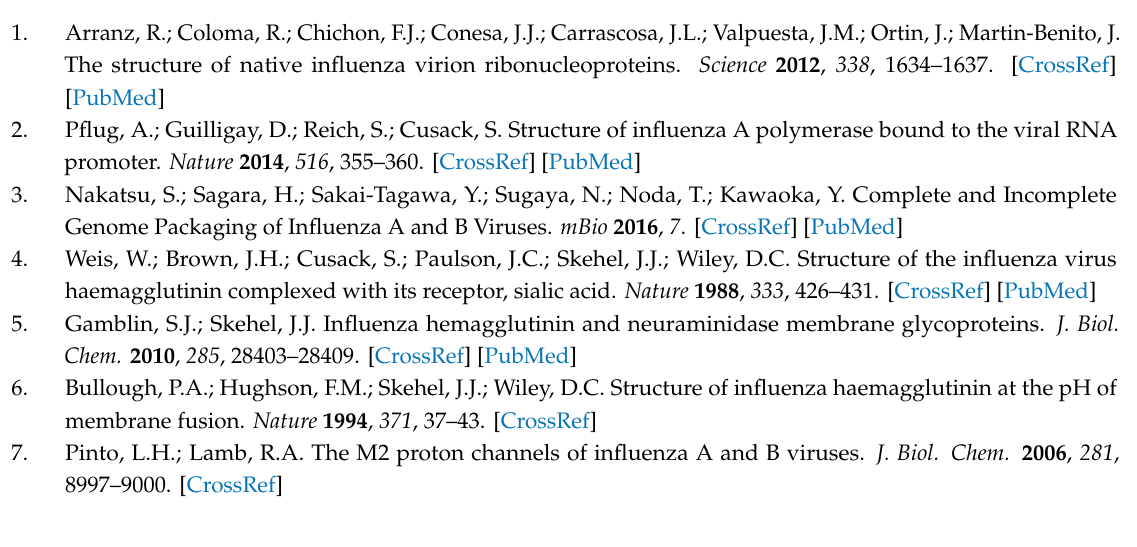
Figure S1: Chemical structure of nylidrin and its analogues, Figure S2: Reduction of a viral protein, nucleoprotein (NP) by nylidrin in human lung epithelial cells, Figure S3: No e ff ect of nylidin on the proton channel activity of influenza viral M2, Figure S4: Increase of mean survival time of maPR8-infected mice by oral administration of